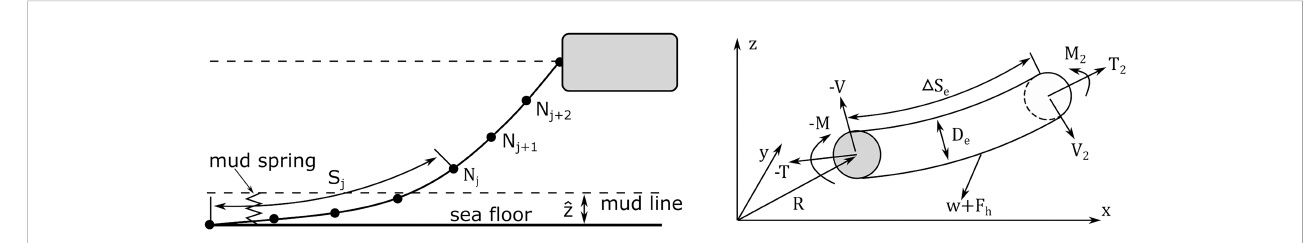
FIGURE 2 Modelling of a catenary mooring cable and forces acting on a cable element, adapted from Jiang et al.